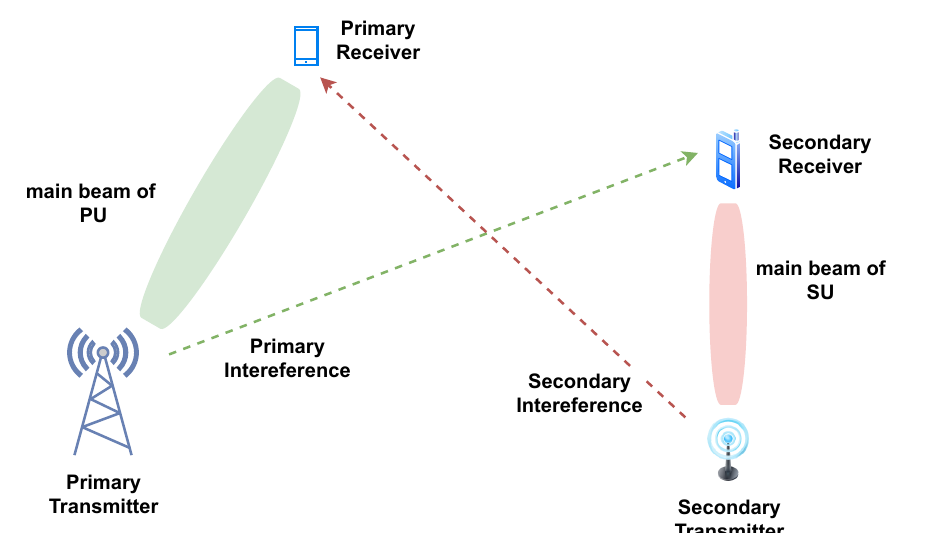
Figure 5. Spatial Dimension of CR application: SU is able to exploit the spatial dimension by transmitting in a non-overlapping direction with the PU transmission. Here, SU should be able to estimate/know the PU beam in order to avoid the